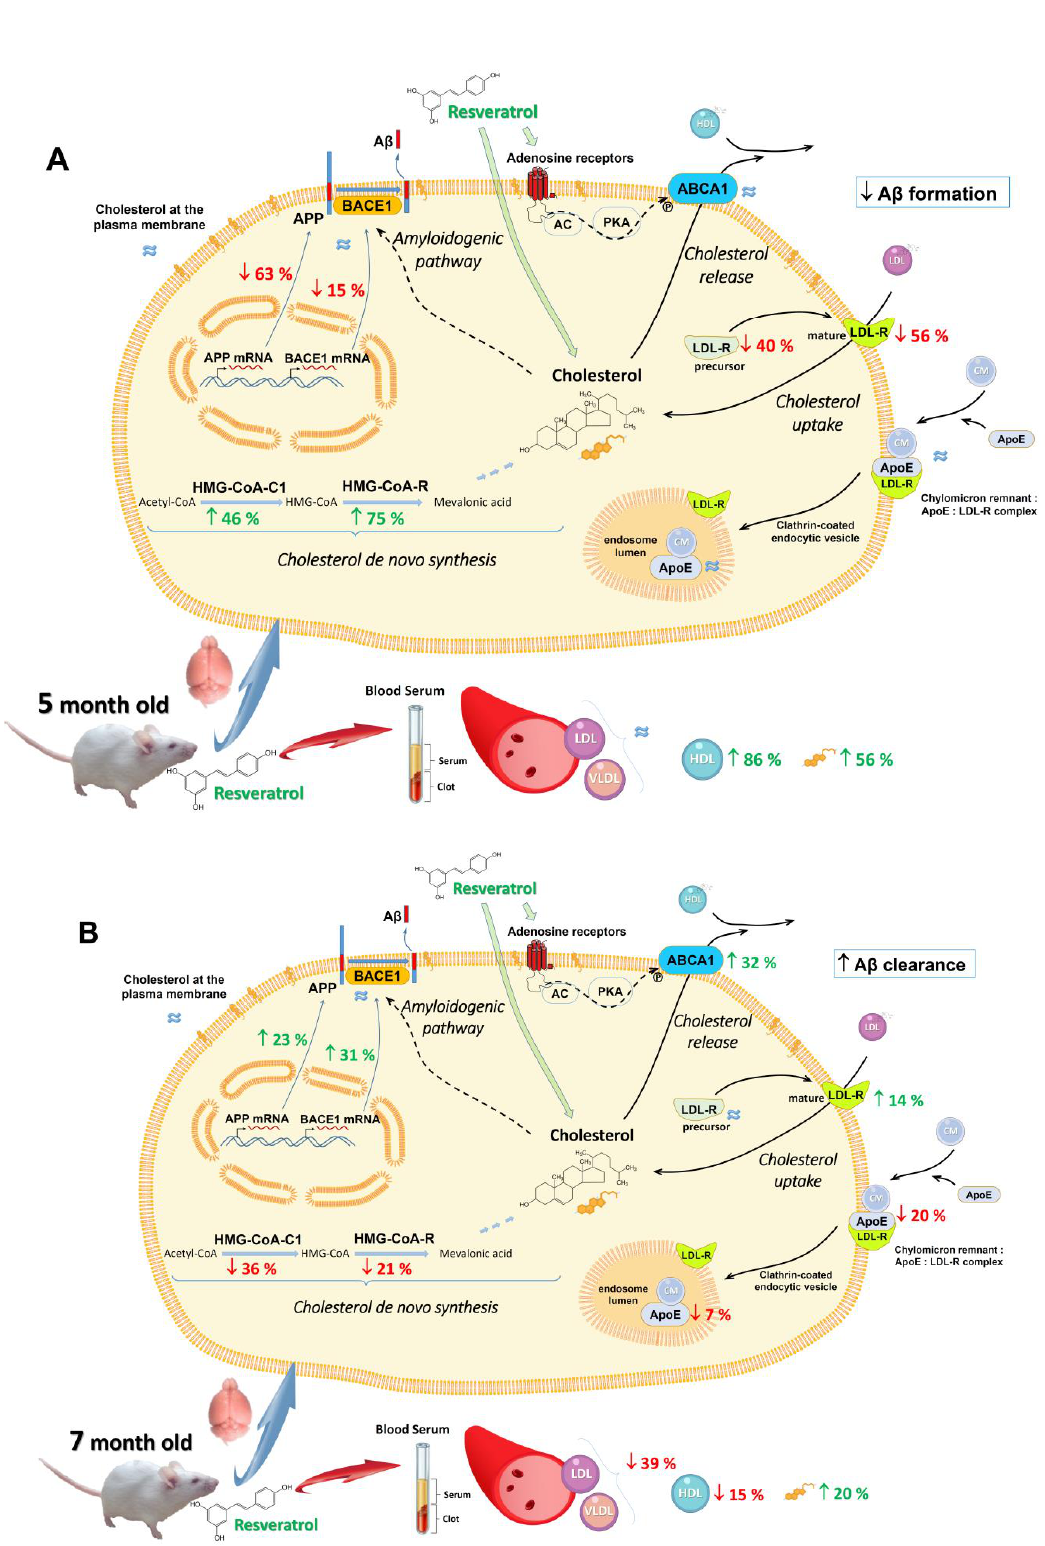
Scheme 1. Resveratrol effect on different key molecular participants controlling